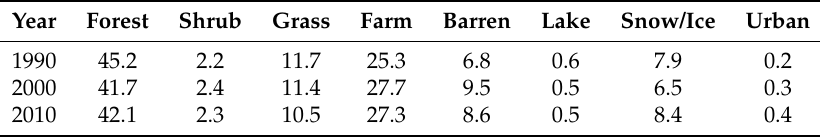
Table 1. Area coverage (%) of Nepal by land cover category and